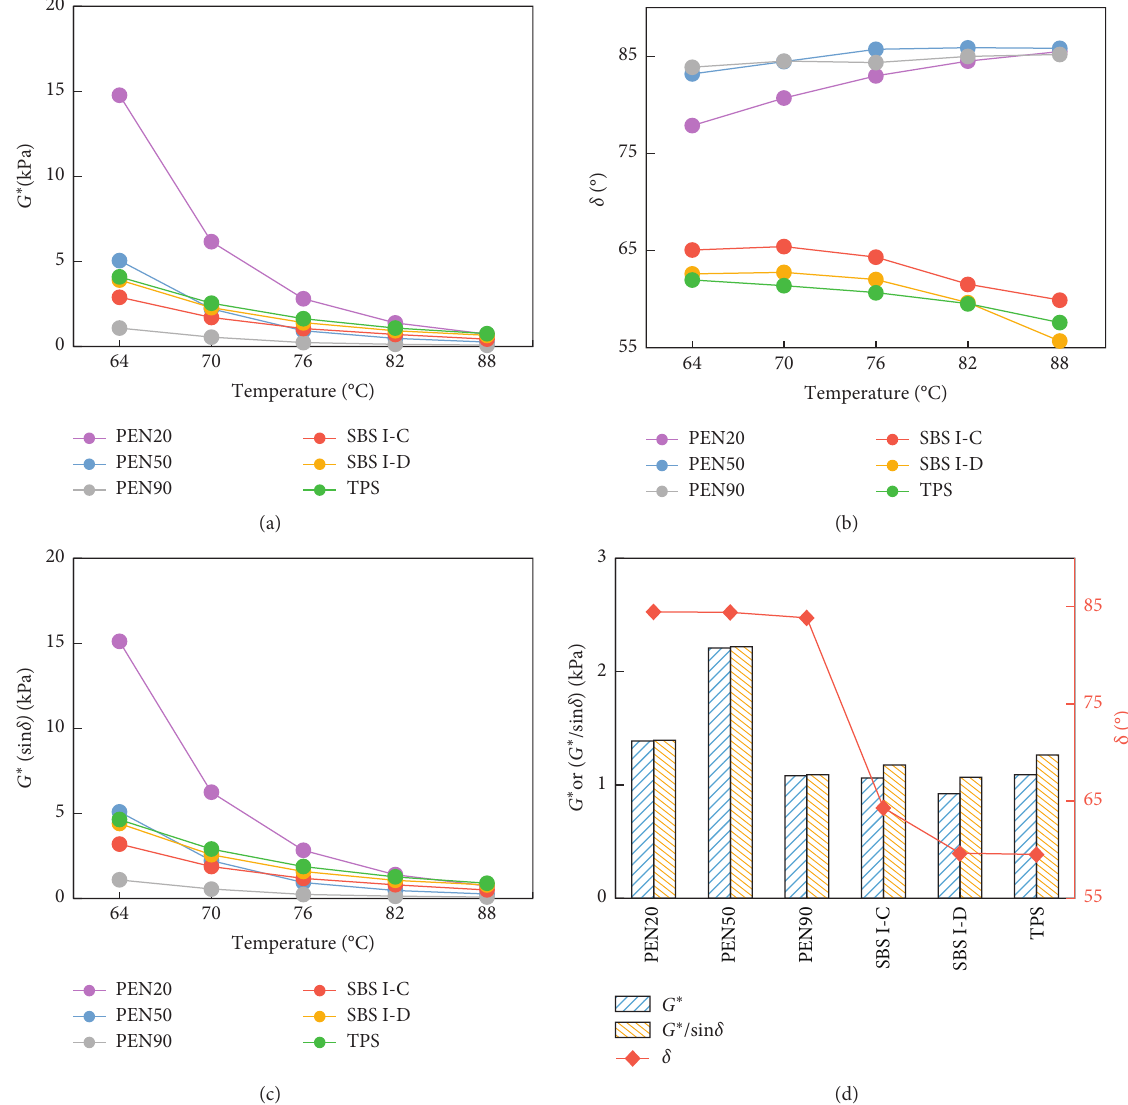
Figure 1: High-temperature rheological properties of six asphalt binders: (a) complex modulus, (b) phase angles, (c) rutting indicator, and (d) rheological parameters at the PG grade